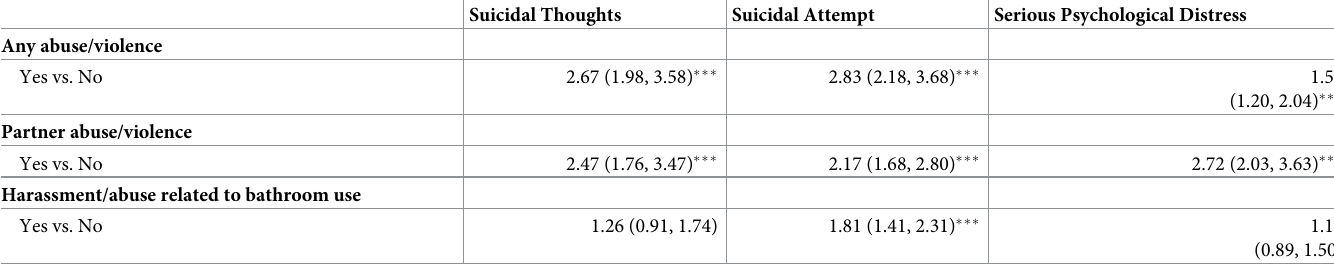
Table 3. Adjusted odds ratio (OR) and 95% confidence interval (CI) of mental health outcomes a , (weighted sample = 1,369).